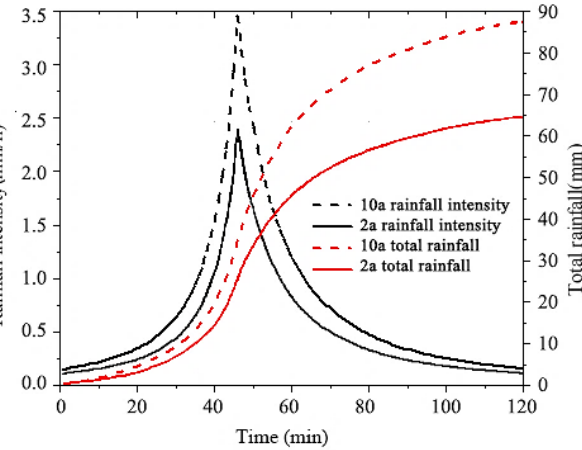
Figure 1. Study area.